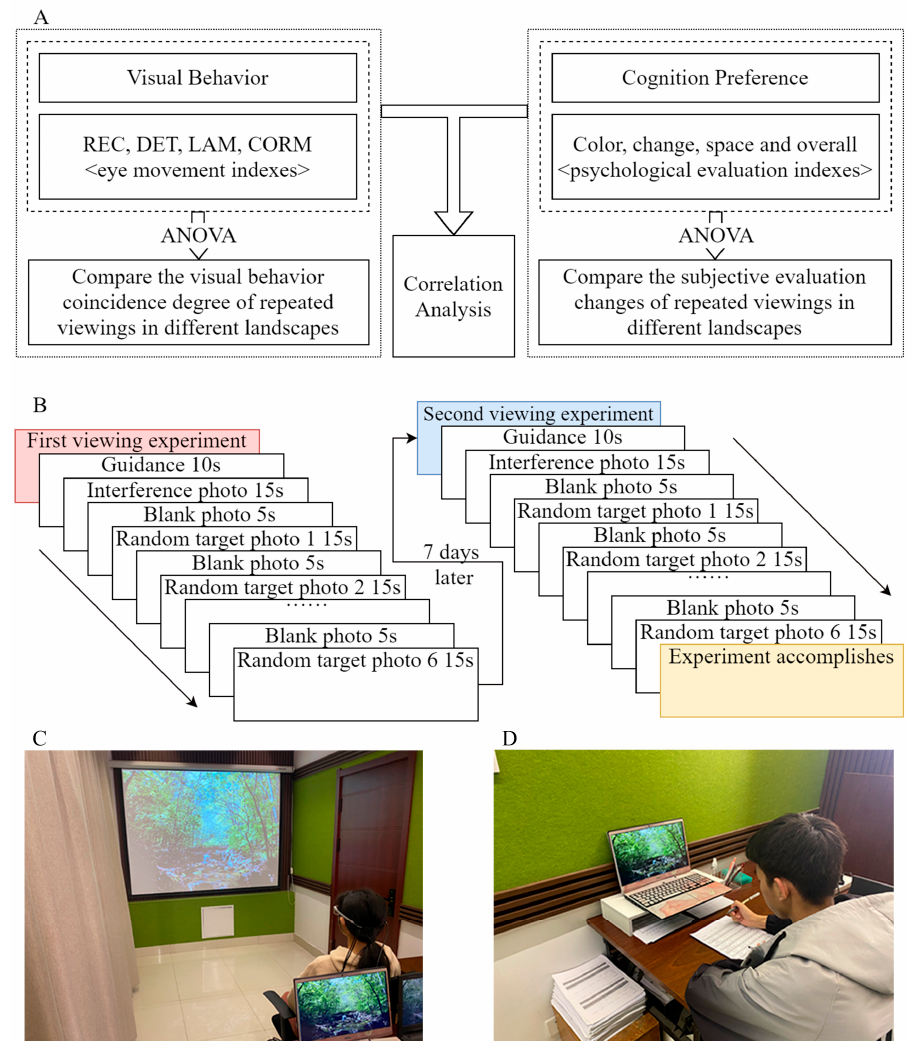
Figure 4. Experimental process and related experimental photos. ( A ) Overall framework of the study. ( B ) The flow of the eye movement experiment. ( C ) On-site photo of eye movement experiments. ( D ) On-site photo of psychological evaluation. The graphics software is Draw.io v13.9.9. This figure was created by the author.